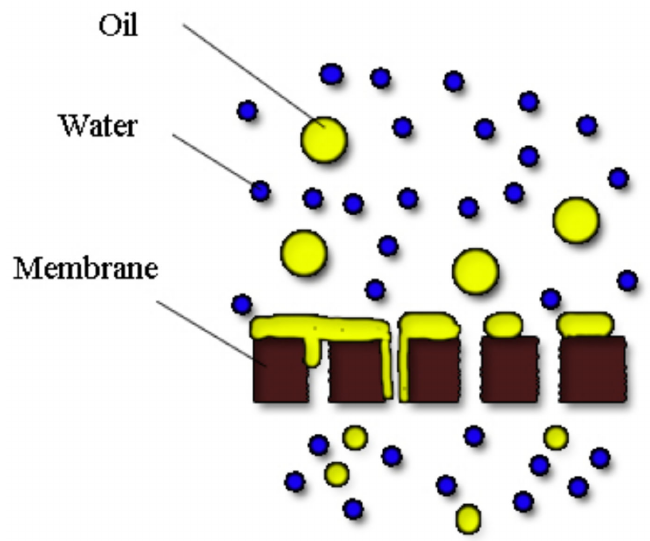
Figure 3. Simplified depiction of oil-water emulsion separation and membrane fouling. Figure 4 represents the schematic overview of hydrophilization methods to reduce the water contact angle [45,46].